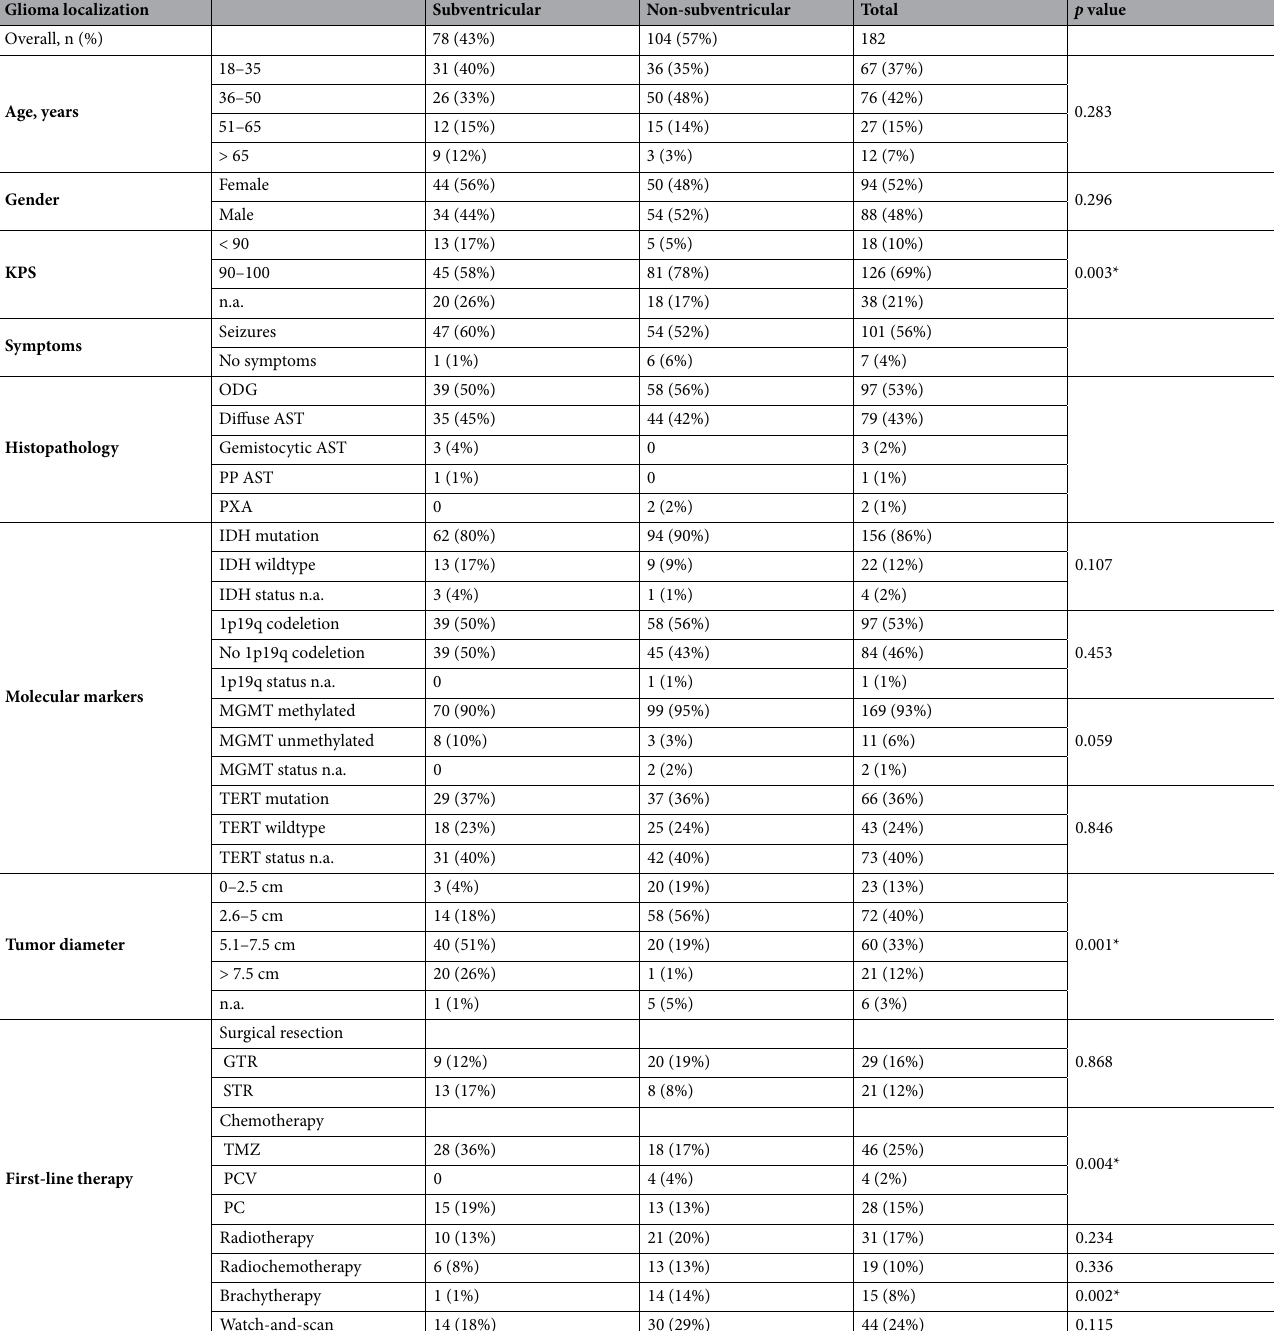
Table 1. Patient characteristics for WHO grade 2 gliomas with and without involvement of the subventricular zone. Characteristics are given for WHO grade 2 glioma patients with involvement of the subventricular zone (subventricular; n = 78), without involvement of the subventricular zone (non-subventricular; n = 104), and are summarized for all patients (total; n = 182). p values are given for numerical and dichotomous variables. Asterisks indicate p ≤ 0.05. AST astrocytoma, GTR gross total resection, IDH isocitrate dehydrogenase 1/2, KPS Karnofsky performance score, MGMT O6-methylguanine-DNA methyltransferase promotor, n.a. not available for review, ODG oligodendroglioma, PC procarbazine, lomustine, PCV procarbazine, lomustine, vincristine, PP protoplasmic, PXA pleomorphic xanthoastrocytoma, STR subtotal resection, TERT telomerase reverse transcriptase promotor, TMZ